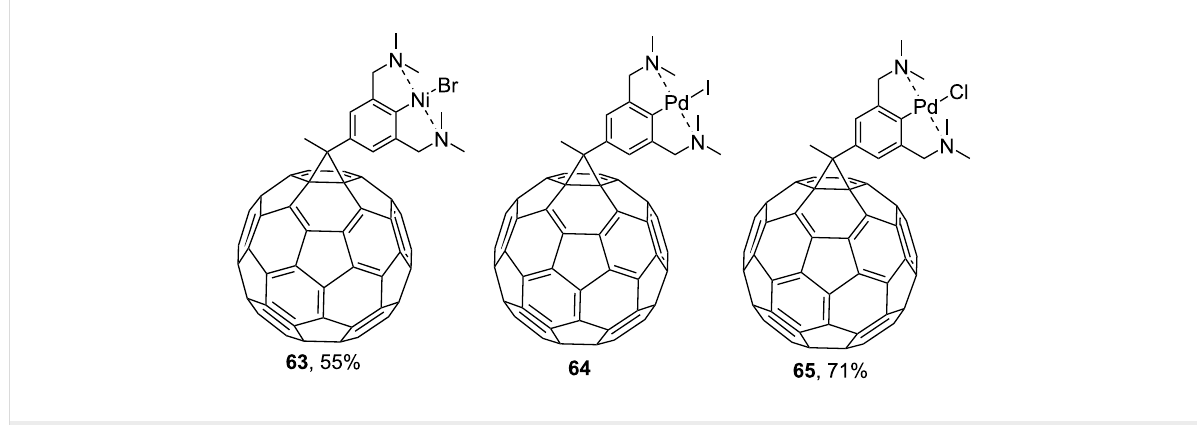
Figure 6: Structures of complexes 63 – 65 .